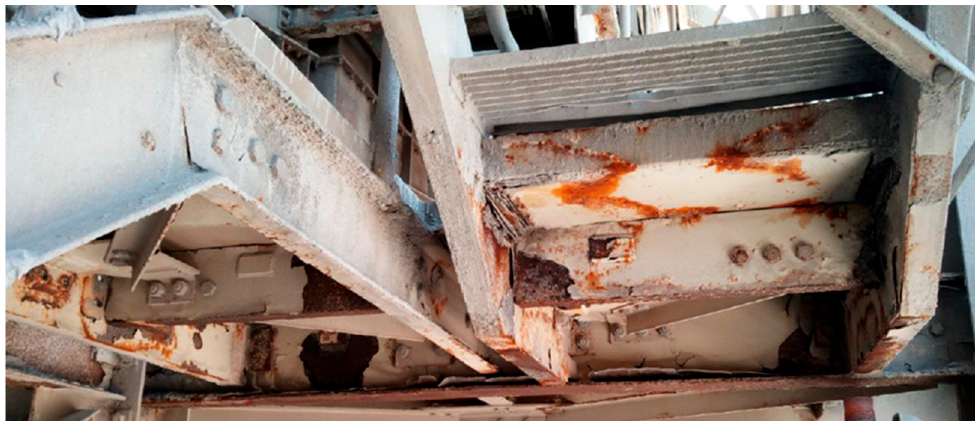
Figure 5. Damaged painting and corrosion centers.